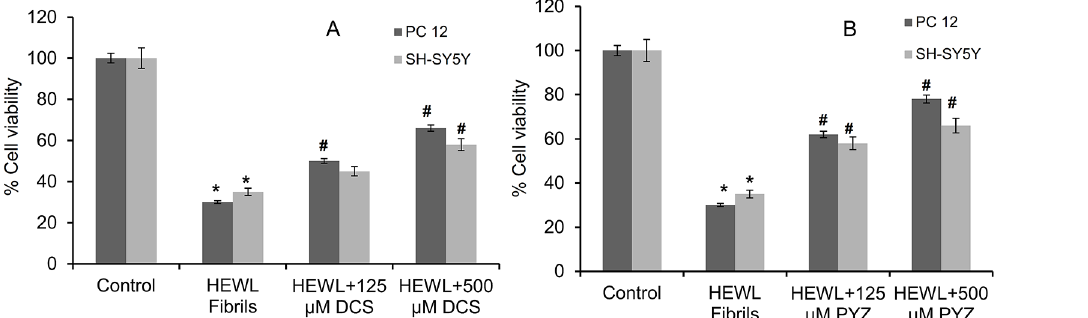
Fig 10. MTT reduction assay for cell cytotoxicity of 120 h aged HEWL amyloid fibrils in SH-SY5Y and PC-12 cell lines in absence and presence of different concentration of (A) DCS and (B) PYZ. Control represents cell lines without prior exposure to HEWL fibrils. * Statistically different from the control group, p (cid:6) 0.05 and # statistically different from the HEWL, p (cid:6) 0.05 for DCS. * Statistically different from the control group, p (cid:6) 0.01 and # statistically different from the HEWL, p (cid:6) 0.01 for PYZ.